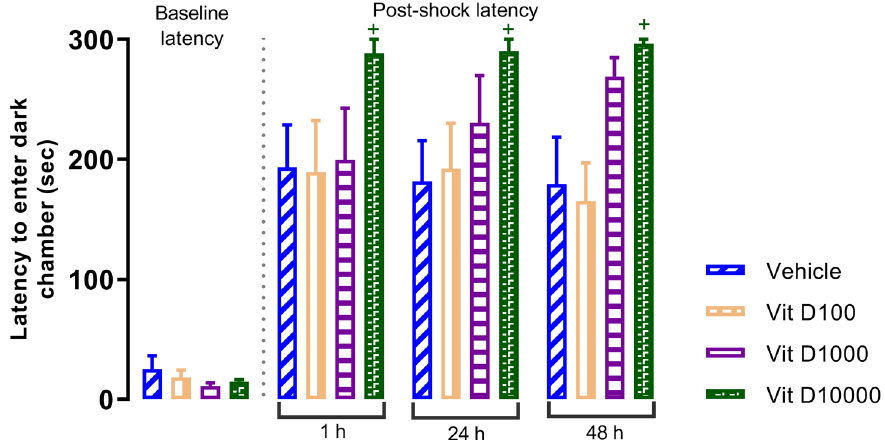
Figure 4. Comparison of latencies to enter dark chamber in Vit D groups. Data are presented as mean ± SEM, n = 10. + P < 0.05 versus Vehicle group.